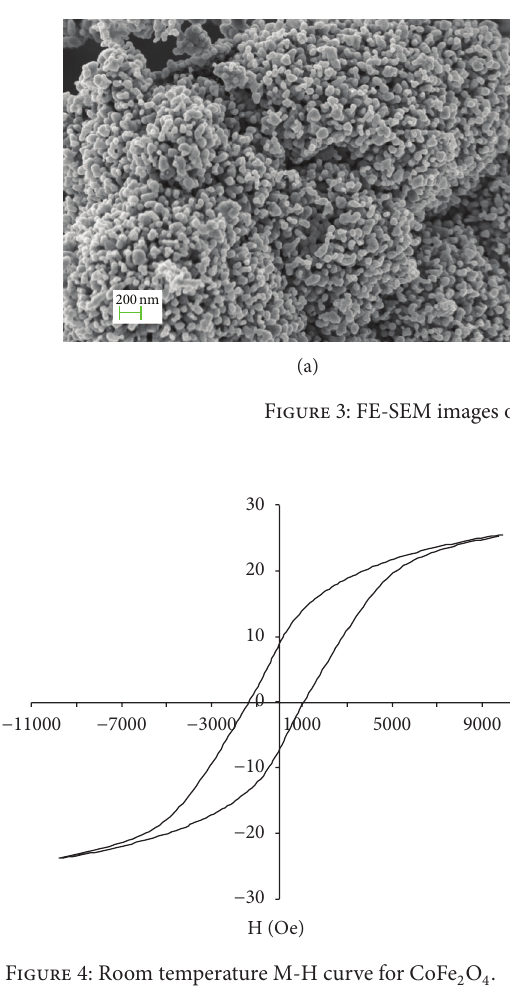
Figure 4: Room temperature M-H curve for CoFe 2 O 4